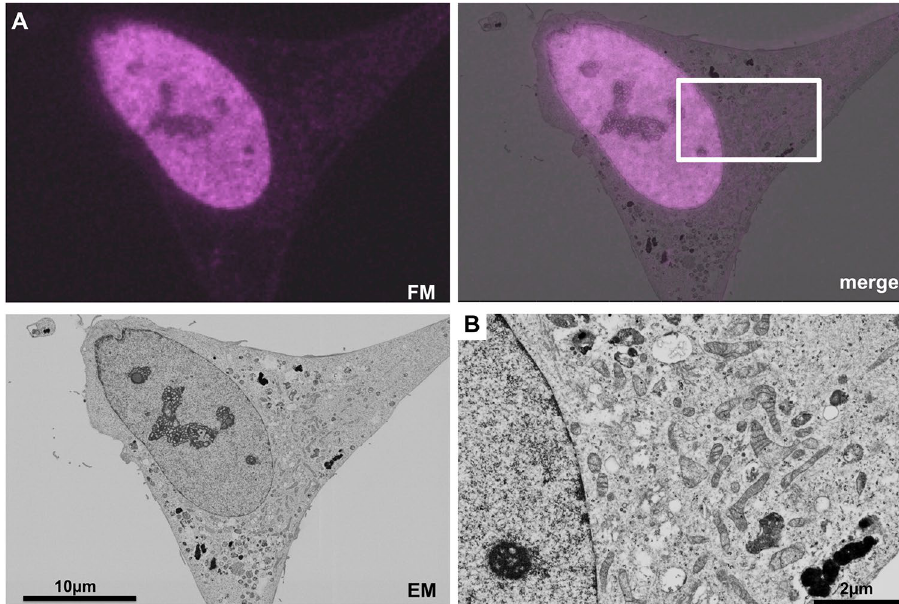
Figure 6. In-resin CLEM of nuclei of Epon-embedded cells was performed using H2B-mTurbo. Thin sections of Epon-embedded cells expressing H2B-mTurbo (magenta pseudo color) were prepared. Fluorescent images ( FM ) and electron microscopic images ( EM ) were obtained as described in Fig. 3. The “ merge ” is a merged image of the fluorescence ( FM ) and electron microscopic images ( EM ). The image in ( B ) indicates × 4 magnification of the electron microscopic image corresponding to the boxed area in the merge image in ( A